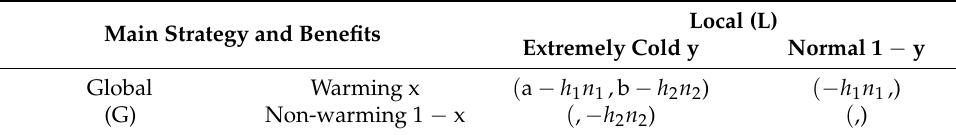
Table 1. Main player strategy and payoff matrix of global and local games. Main Strategy and